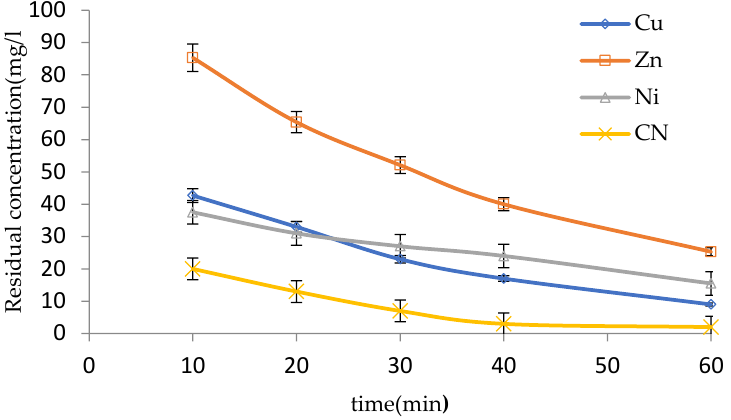
Figure 11. The effect of (PECHp) process for simultaneous removal of pollution with real wastewater. The highest removal efficiency of nickel, cyanide, zinc, and copper was 58, 90, 70, and 78% after 60 min of photo-electrocoagulation-oxidation process. Considering the presence